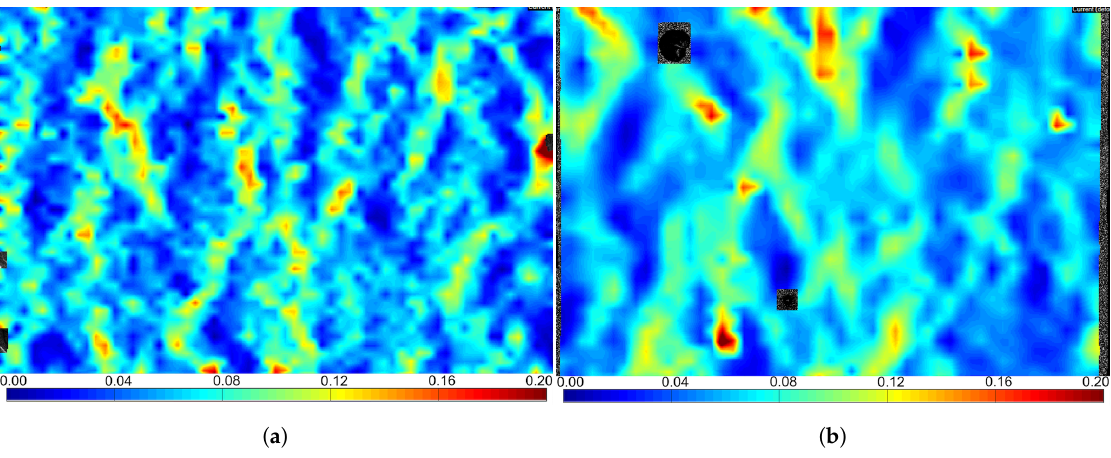
Figure 16. Comparing the two techniques when having the same mesh size (in µm): ( a ) etched specimen with an area of 141 µm × 98 µm; and ( b ) gold speckled specimen with an area of 114 µm × 85